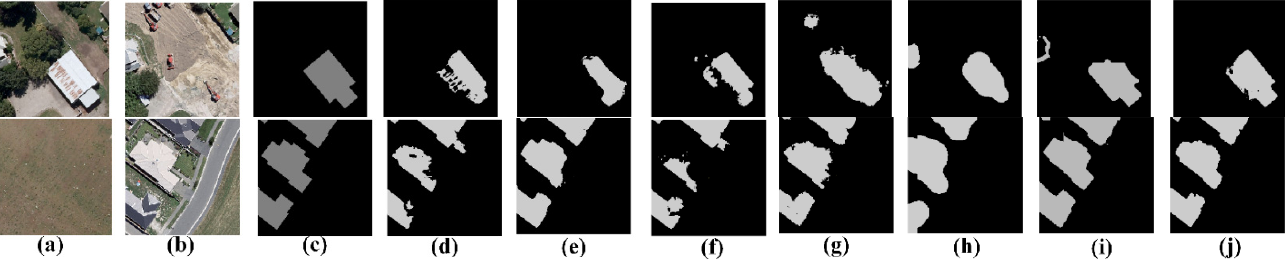
Figure 10. ( a ) Before image. ( b ) After image. ( c ) Label. ( d ) FC-EF. ( e ) FC-Siam-conc. ( f ) FC-Siam-diff. ( g ) SegNet. ( h ) DASNet. ( i ) STANet. ( j ) Ours.